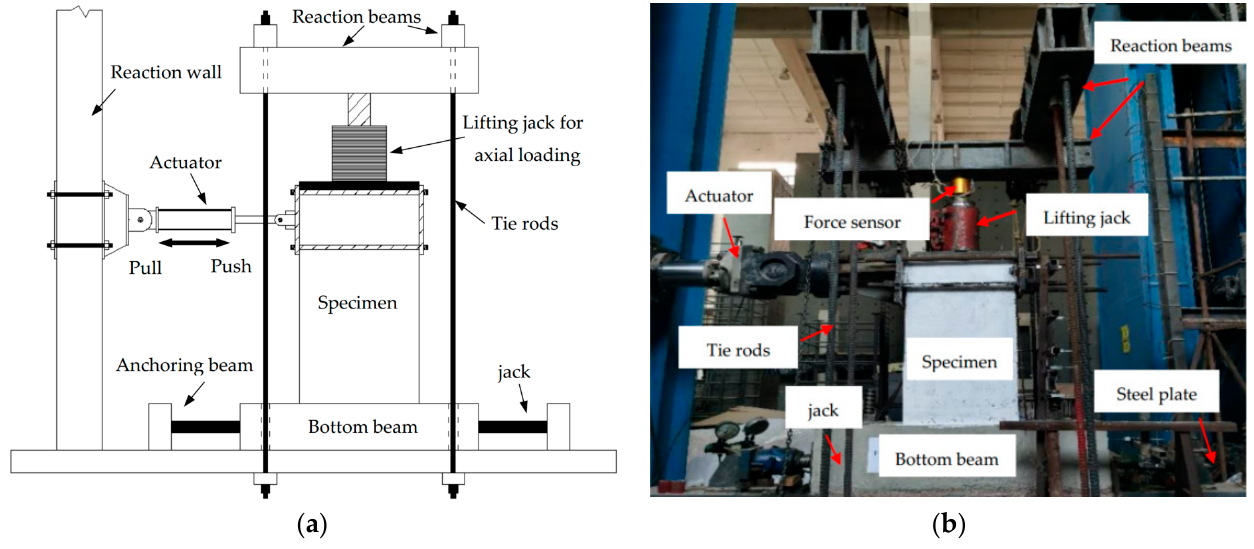
Figure 3. Schematic diagram of the loading device for specimens: ( a ) schematic diagram of the loading process and ( b ) a photograph of the setup.